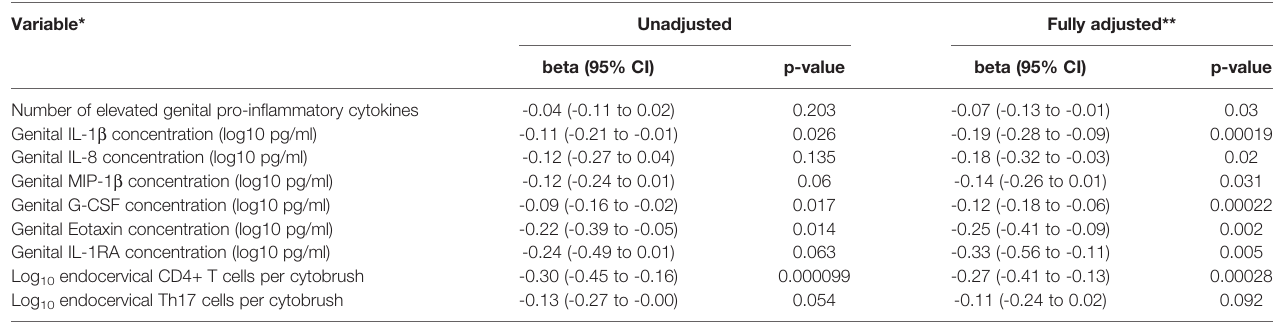
TABLE 3 | Multivariable models of endocervical Treg frequency.